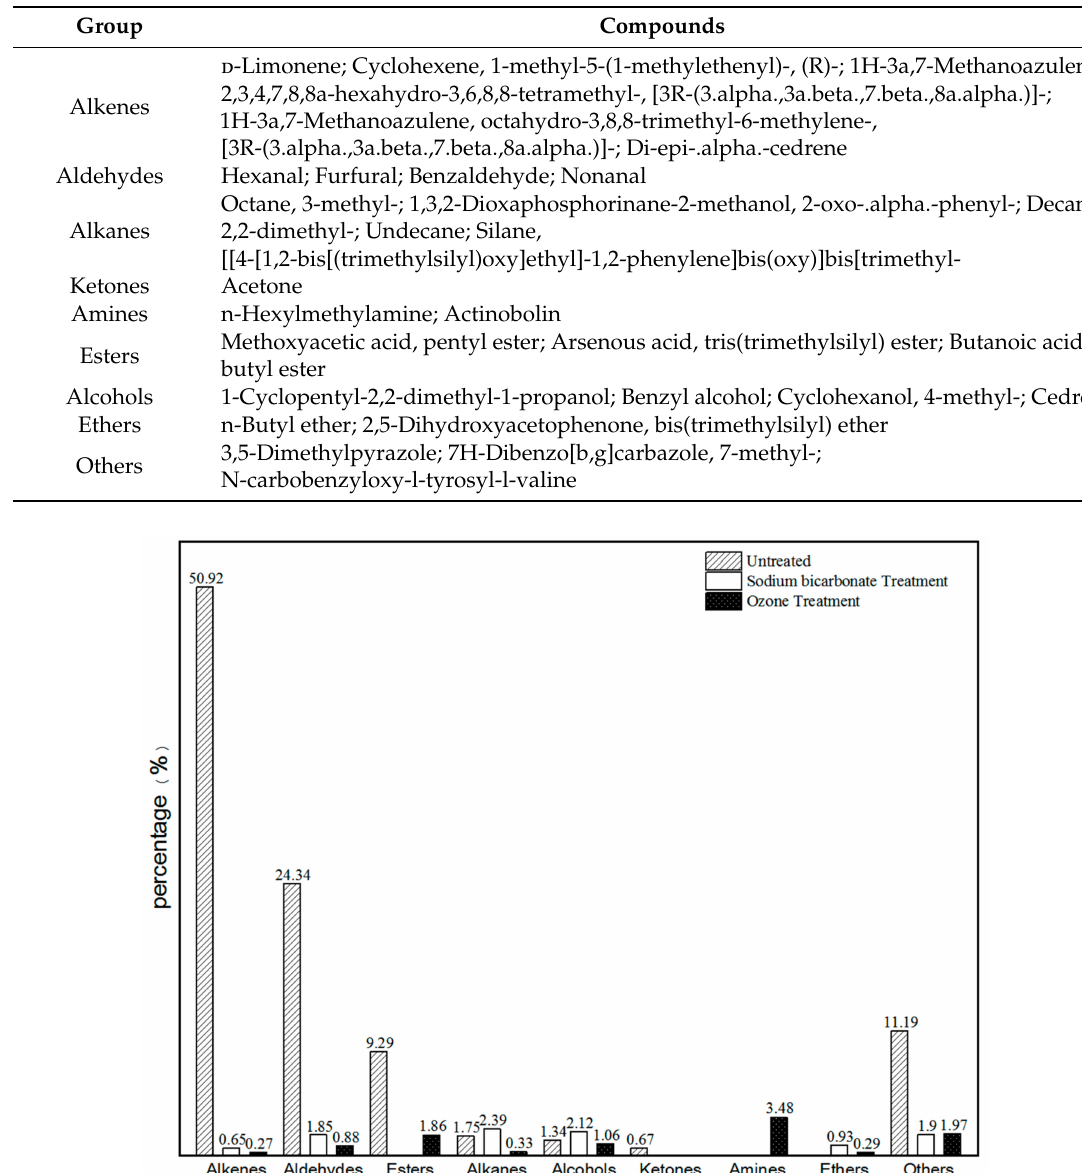
Table 4. Main VOCs of RP before and after treatment.